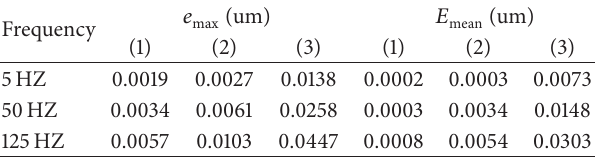
Table 1: Comparison of positioning control